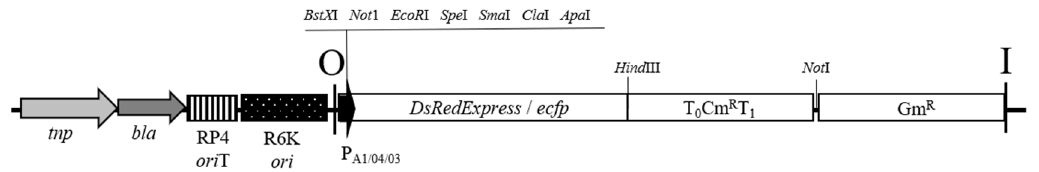
Figure 1. Schematic representation of the cloning vectors pCAT14 ( ecfp ) and pCAT30 ( DsRedExpress ). Adapted from [22]: tnp , Tn5 transposase; bla , lactamase encoding gene; oriT RP4, transfer origin; ori R6K, origin of replication; I and O, inner and outer ends of IS50; and Gm R , the gentamycin resistance gene. The P A1 / 04 / 03 constitutive promoter, DsRedExpress or eCFP genes, and T 0 Cm R T 1 sequences are as described by [27]. Useful, known restriction sites are indicated. The figure is not drawn to scale.